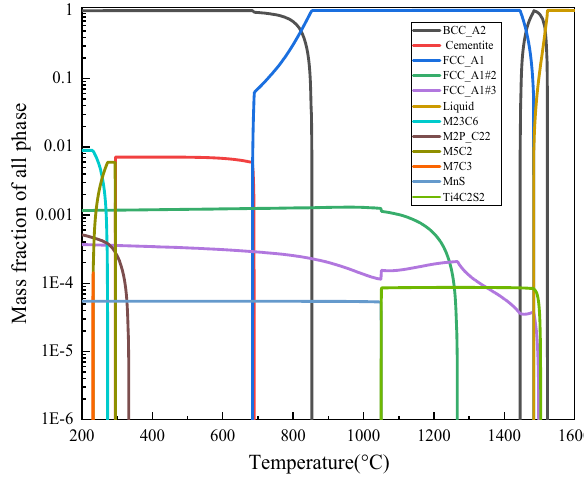
Figure 2: Relationship between the precipitation of the second phase and